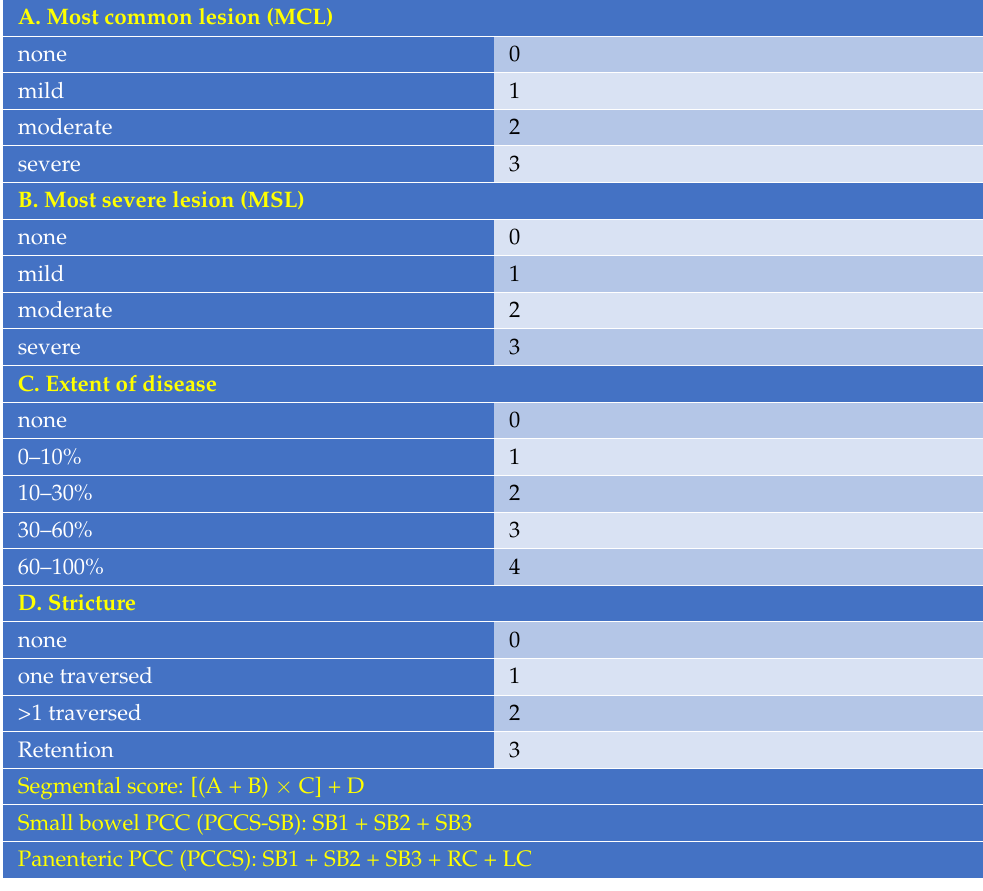
Table 3. PillCam CD Inflammatory score—Eliakim